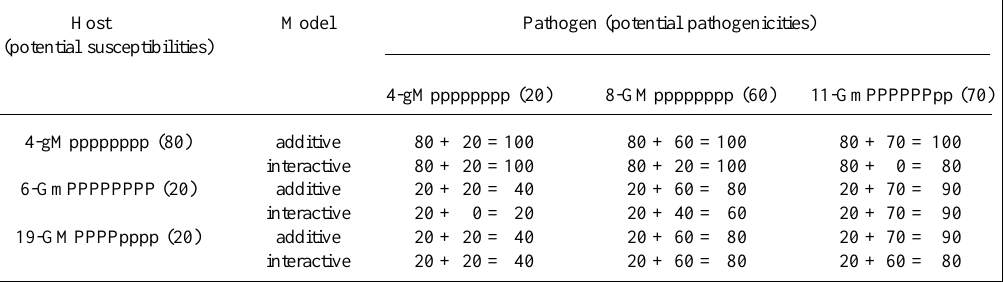
Table II - Disease severity (%) of some host-pathogen interactions according to additive and interactive models.